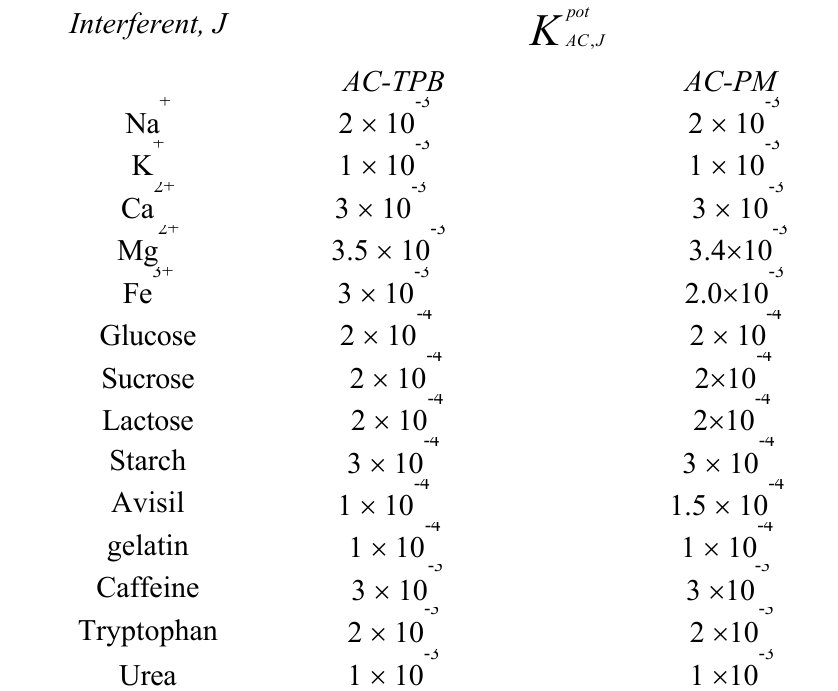
) for the two proposed sensors. JAC ,